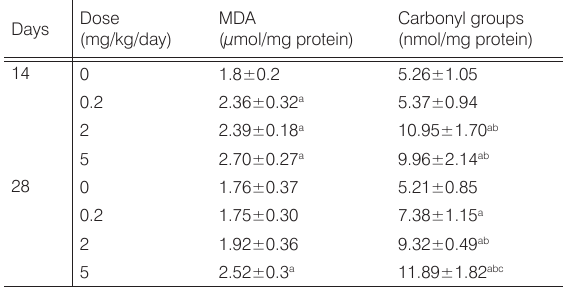
Table 1 Rats brain malonyldialdehyde and carbonyl groups levels in sub-chronic intoxication with chlorpyrifos. Dose MDA Days (mg/kg/day) (µmol/mg protein)